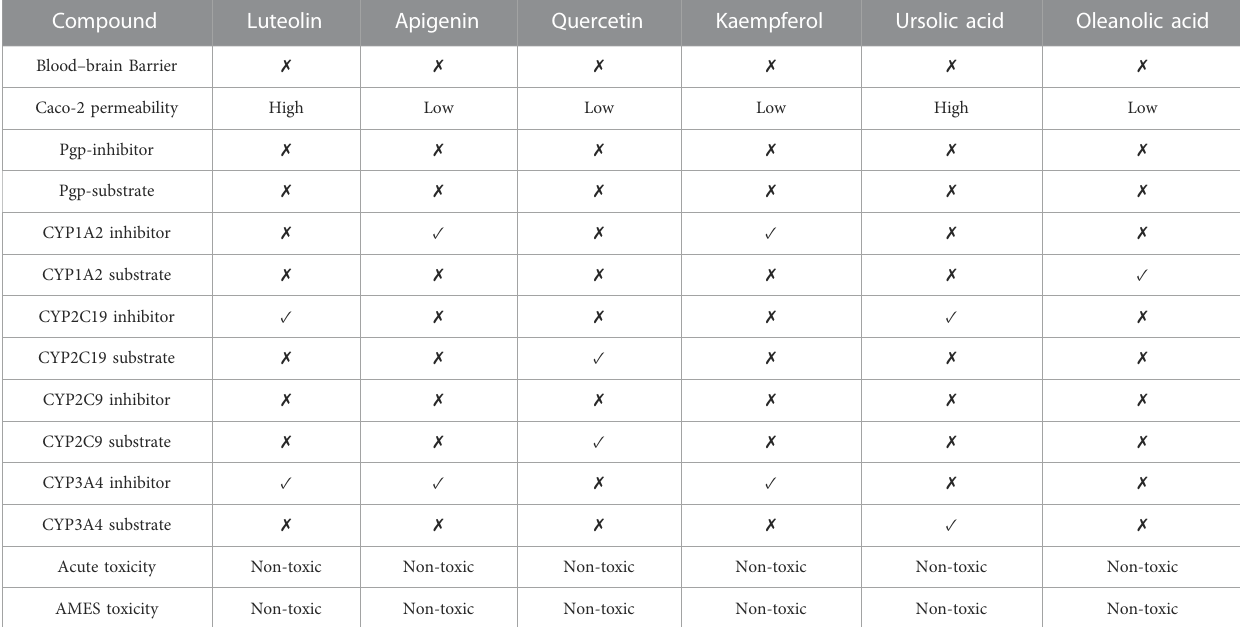
TABLE 2 ADMET pro fi ling of selected